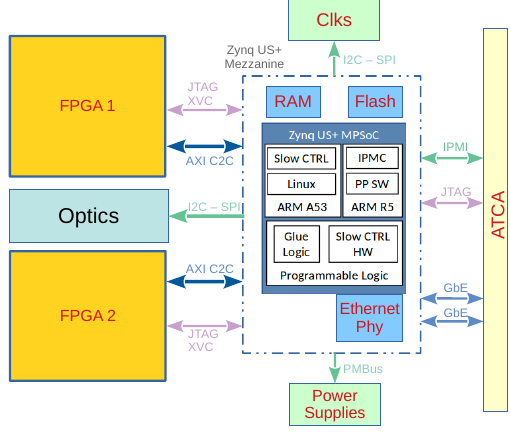
Figure 2: Unified slow control